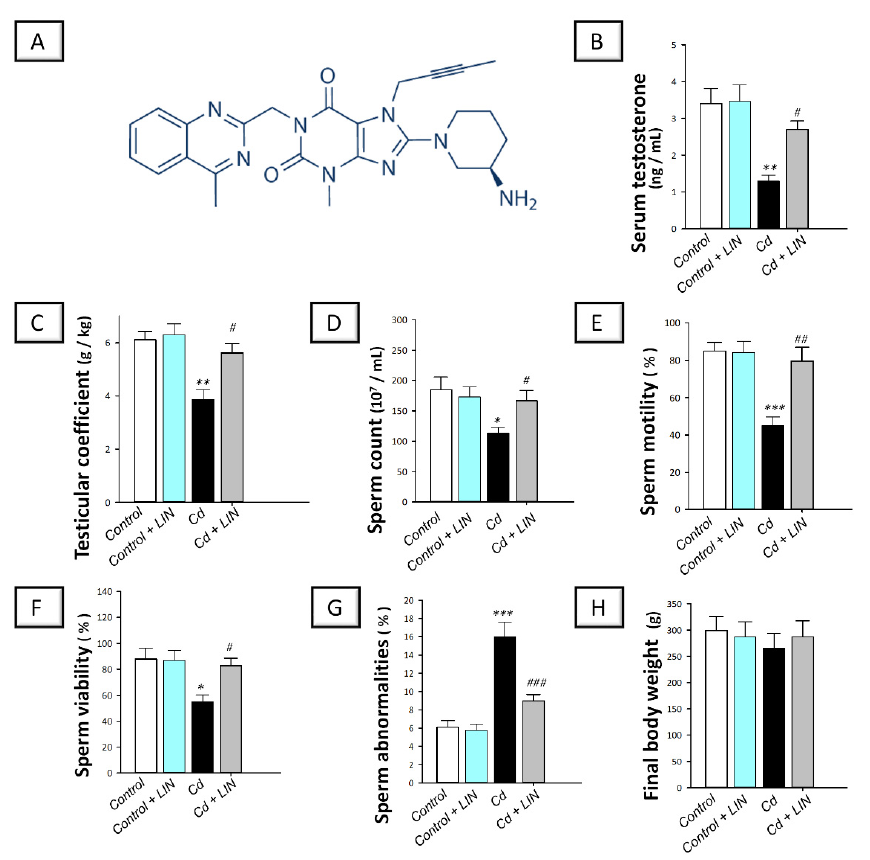
Figure 1. Effect of cadmium and/or linagliptin administration on testicular dysfunction and sperm parameters in rats. The co-treatment with linagliptin (the chemical structure displayed in ( A ) rescued the testicular dysfunction and improved the sperm abnormalities that were instigated by cadmium metal. This was demonstrated by increase of serum testosterone ( B ), testicular coefficient ( C ), sperm count ( D ), sperm motility ( E ), and sperm viability ( F ), alongside lowering sperm abnormalities ( G ), without affecting the final body weight ( H ). * p < 0.05, ** p < 0.01, and *** p < 0.001 show statistical significance compared to the group of control rats; # p < 0.05, ## p < 0.01, and ### p < 0.001 show statistical significance compared to the group of cadmium ‐ intoxicated rats. Values are stated as the mean ± standard error of the mean for 6 animals per group. LIN, linagliptin; Cd, cadmium chloride.